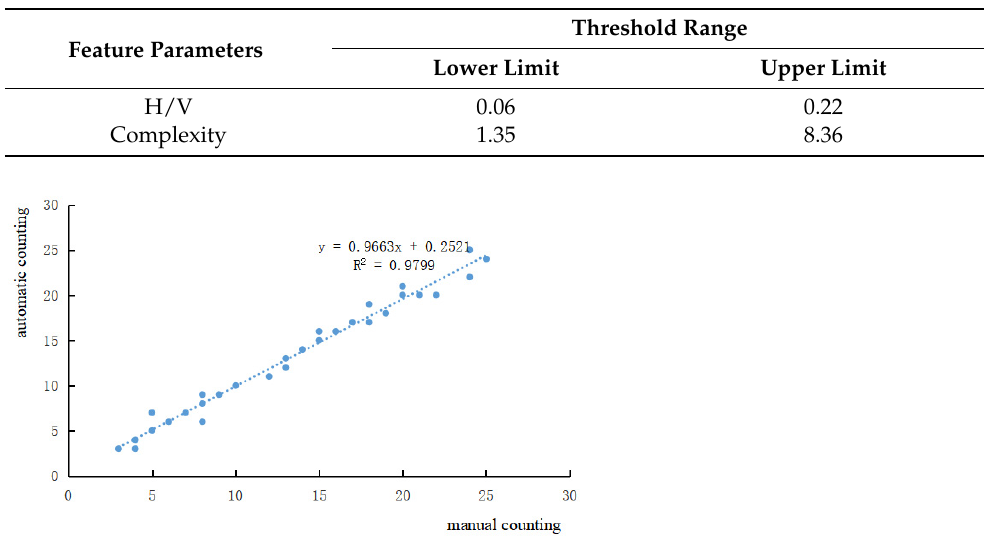
Figure 11. Linear regression between automatic and manual counting of S. frugiperda .